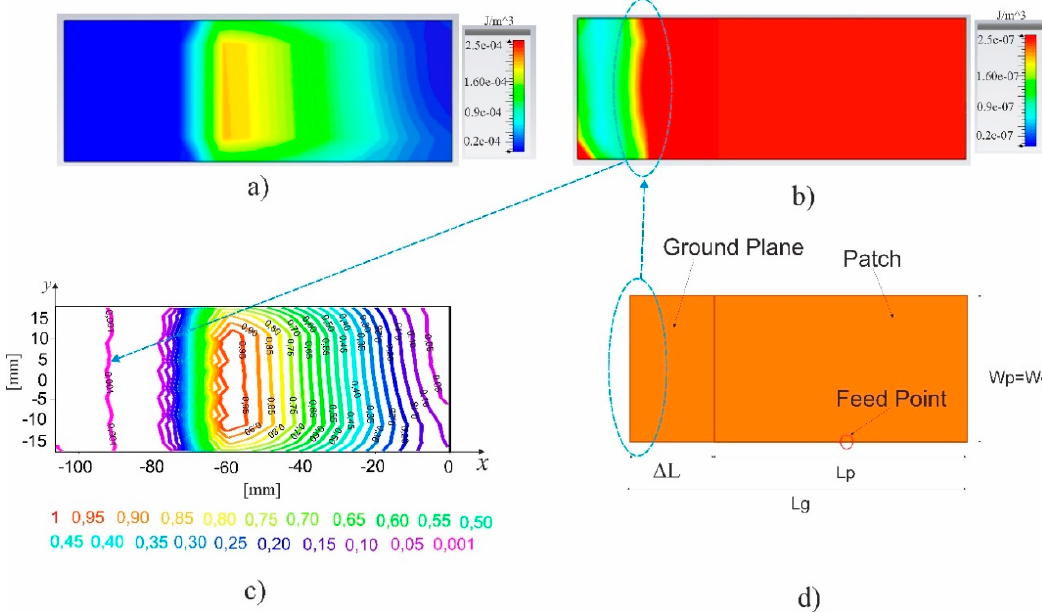
Figure 8. ( a ) Electric energy density on the ground plane for the antenna with ∆ L = 40 mm. ( b ) Electric energy density on the ground plane for the antenna with ∆ L = 40 mm with the maximum peak set to a value 10 3 times lower than the one shown in ( a ). ( c ) Normalized electric energy density on the ground plane for the antenna with ∆ L = 40 mm represented with contour lines. ( d ) Profile of the extended ground plane following the electric energy density shown in ( b ), with ∆ L = 32.5mm.